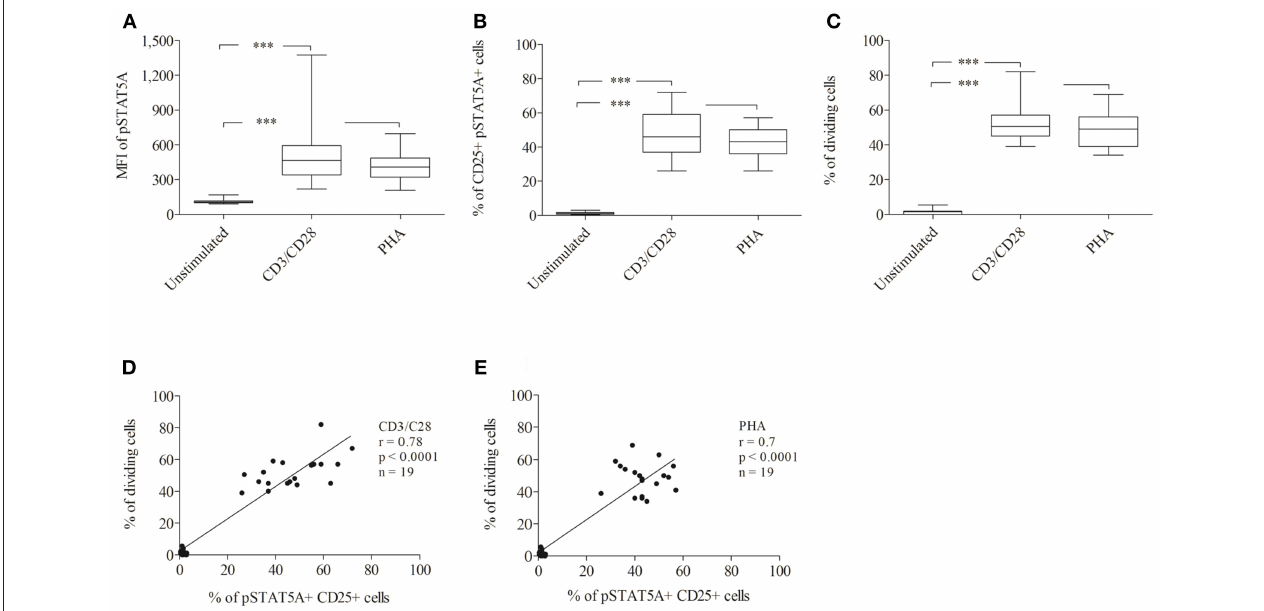
FIGURE 7 | Analysis of STAT5A phosphorylation and percentage of CD25 + pSTAT5A + cells and dividing cells by flow cytometry ( n = 19). T cells were stimulated with CD3/CD28 or PHA. After 24h the MFI of STAT5A (A) the percentage of CD25 + pSTAT5 + cells (B) and after 72h proliferations (C) were determined. The correlation between the percentage of dividing cells (72h) and percentage of CD25 + pSTAT5A + cells (24h) (D) CD3/CD28, (E) PHA. The bold line inside each box plot shows the median, upper and lower lines indicate the maximum and minimum values, respectively. *** p < 0.001 (Wilcoxon’s test); r, Spearman’s correlation coefficient; MFI, median fluorescence intensity.